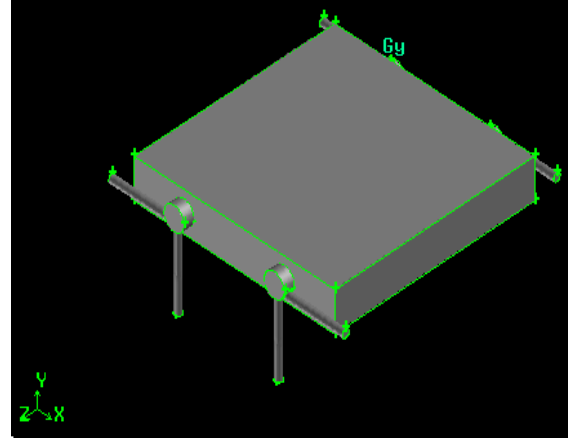
Figure 1. Swirling combustor converter, length/diameter ratio ( Z / D ) = 11.